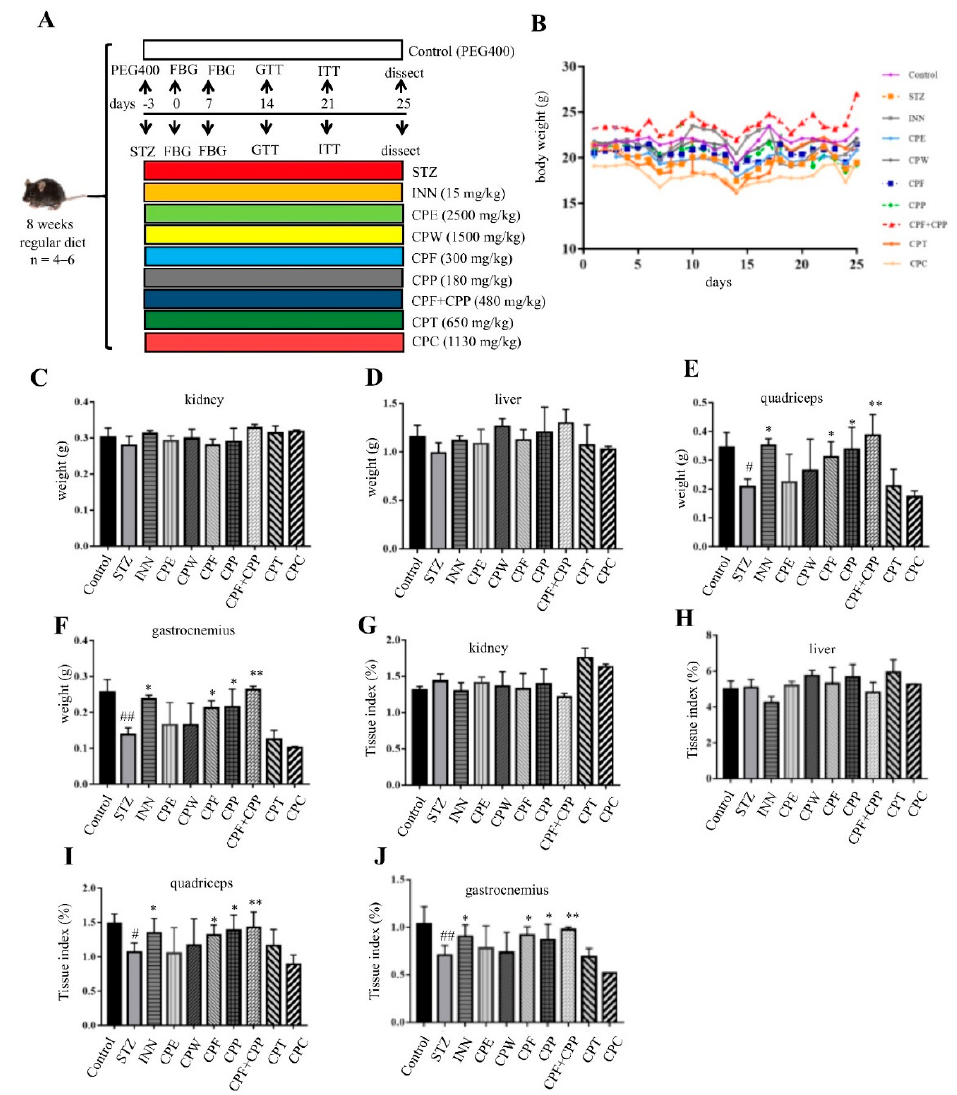
Figure 1. CPF (flavonoids fraction from C. paliurus leaves) and CPP (polysaccharide fraction from C. paliurus leaves) reverse body weight and muscle weight losses in STZ (streptozotocin)-induced diabetic mice. ( A ) The experiment procedure for STZ-induced diabetic mice. The male C57BL/6J mice were ip administrated with 150mg/kg STZ, and then the mice were orally administrated with or without C. paliurus fractions once a day for 24 days. INN (glibenclamide, 15 mg/kg); CPE (ethanol extract from C. paliurus leaves, 2500 mg/kg); CPW (water extract from C. paliurus leaves, 1500 mg/kg); CPF (300 mg/kg); CPP (180 mg/kg); CPF+CPP (flavonoids and polysaccharide fractions from C. paliurus leaves, 480 mg/kg); CPT (triterpenoids fraction from C. paliurus leaves, 650 mg/kg); CPC (flavonoids, polysaccharide, and triterpenoids fractions from C. paliurus leaves, 1130 mg/kg). ( B ) Bodyweight of mice. ( C ‒ F ) Kidneys, liver, quadriceps, and gastrocnemius weights of each group. ( G ‒ J ) Tissue indexes of kidneys, liver, quadriceps, and gastrocnemius. n = 6. # p < 0.05, ## p < 0.01, STZ vs. control, * p < 0.05, ** p < 0.01, STZ vs. treatment.